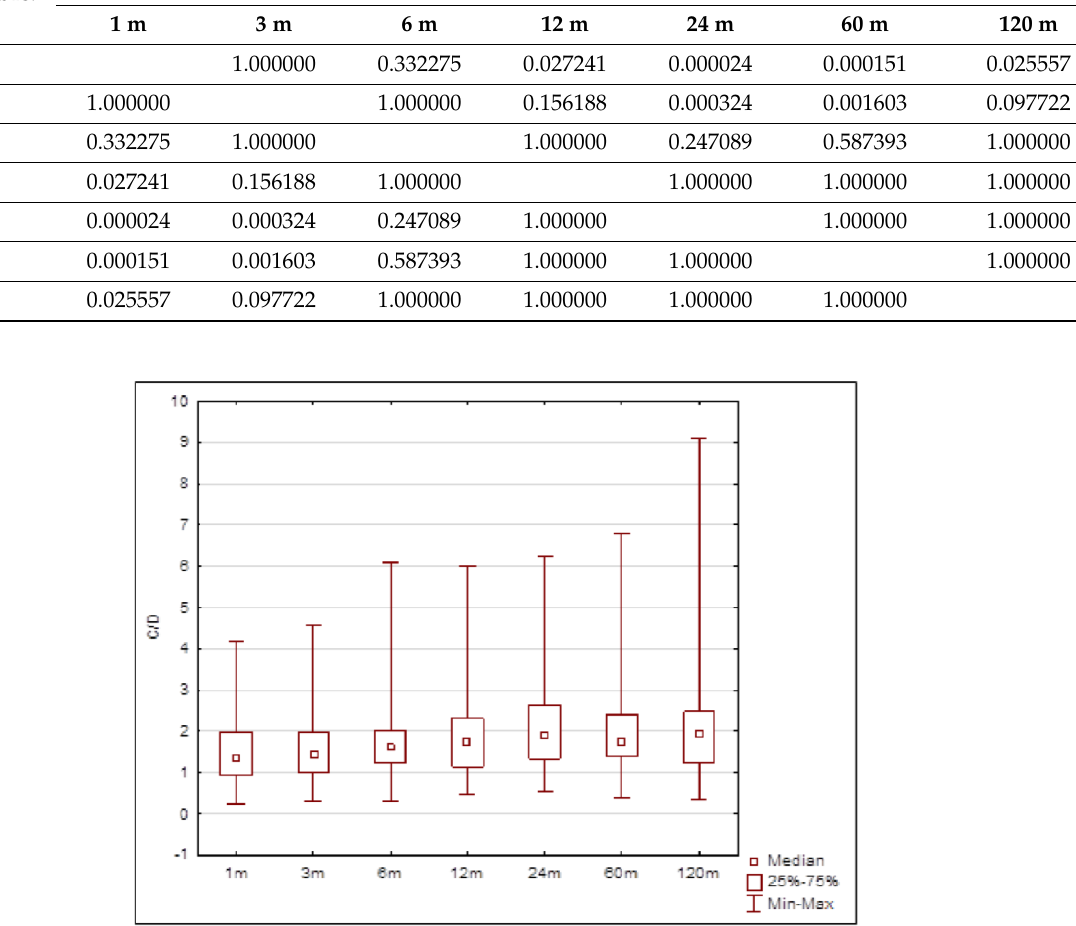
Figure 4. C/D ratio from different points after kidney transplantation. Statistically significant differences are shown in Table 1.